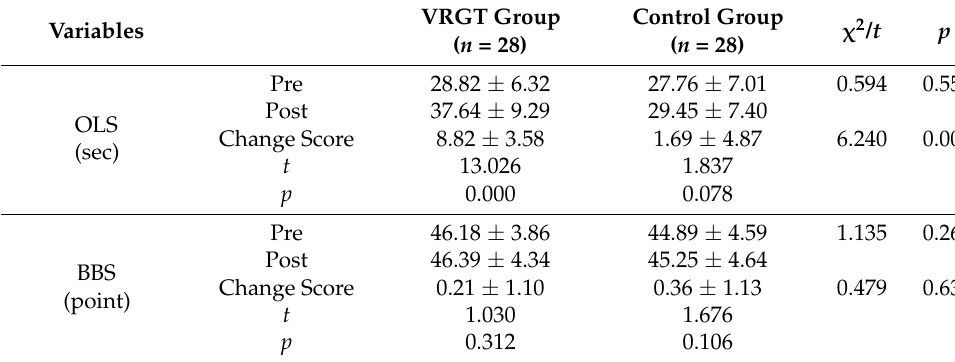
Table 2. Changes of postural